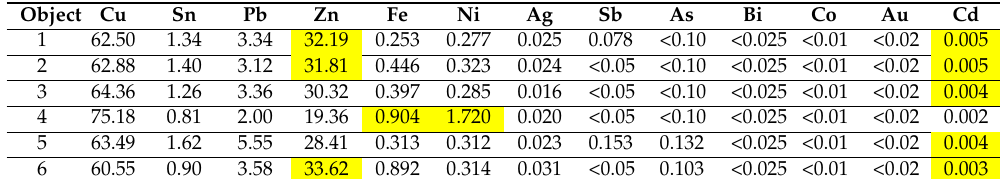
Table 1. Results of atomic absorption spectrometry (AAS)-analysis (in Mass%, Cu = 100% − Σ % all other elements) (concentrations contradicting alleged production date are indicated in yellow).